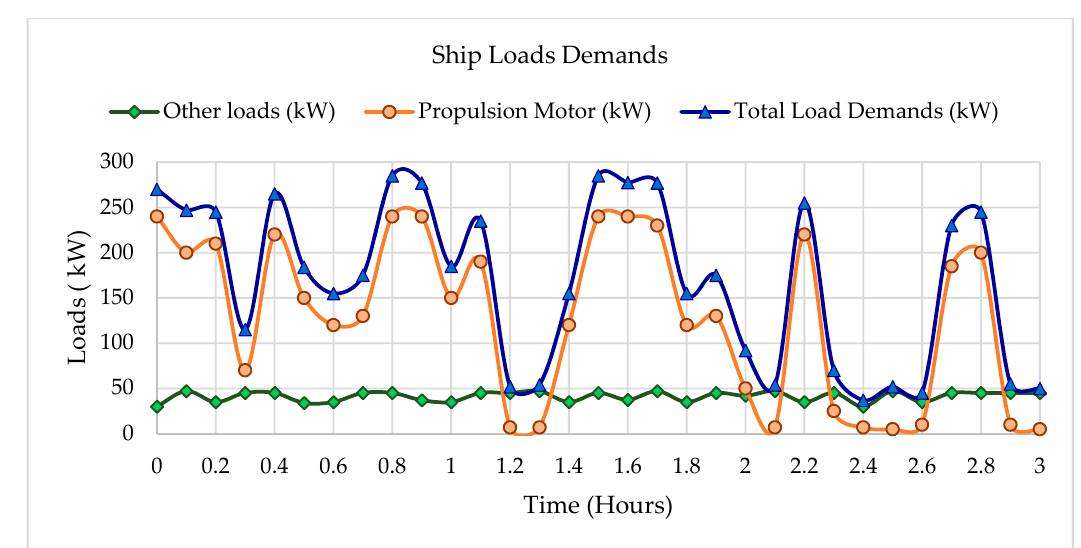
Figure 2. Estimated Ship Load Demands on a 3 h basis.